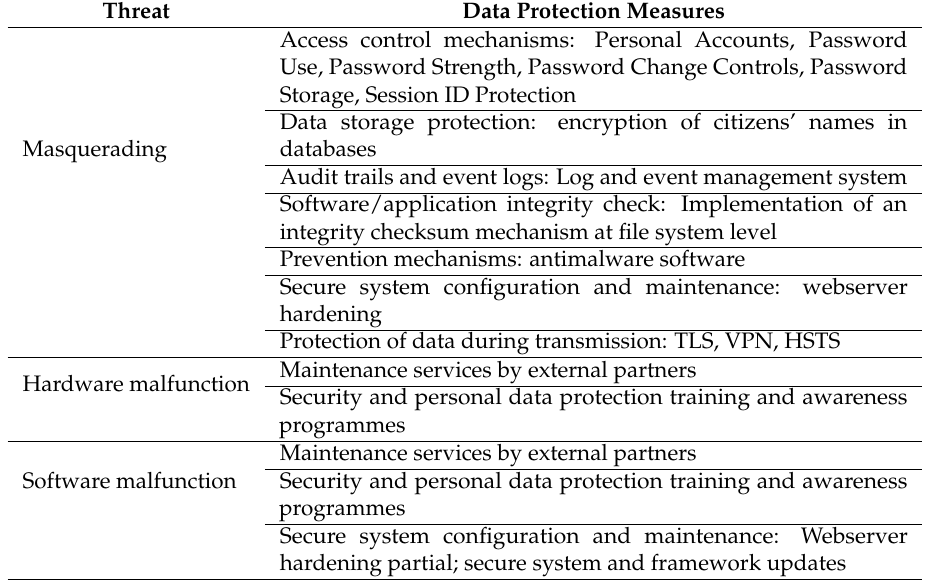
Table 6. Data protection measures for risk category: Unwanted modification of data.